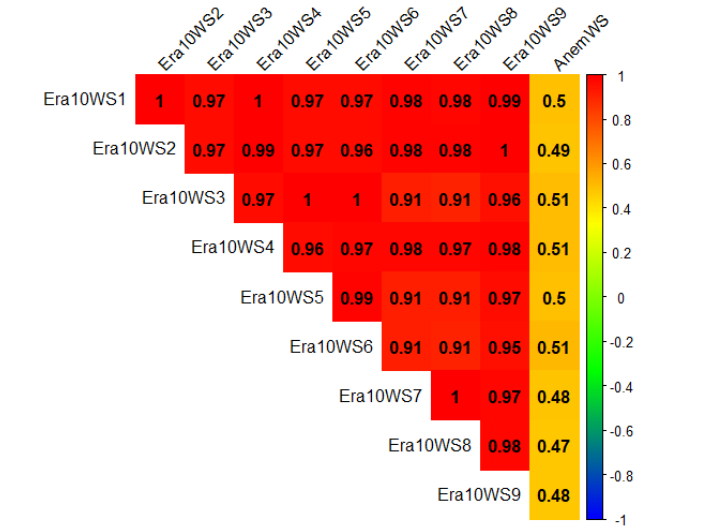
Figure 10. Correlation table of the wind speed series from each ERA5 grid point and the measured wind speed series.